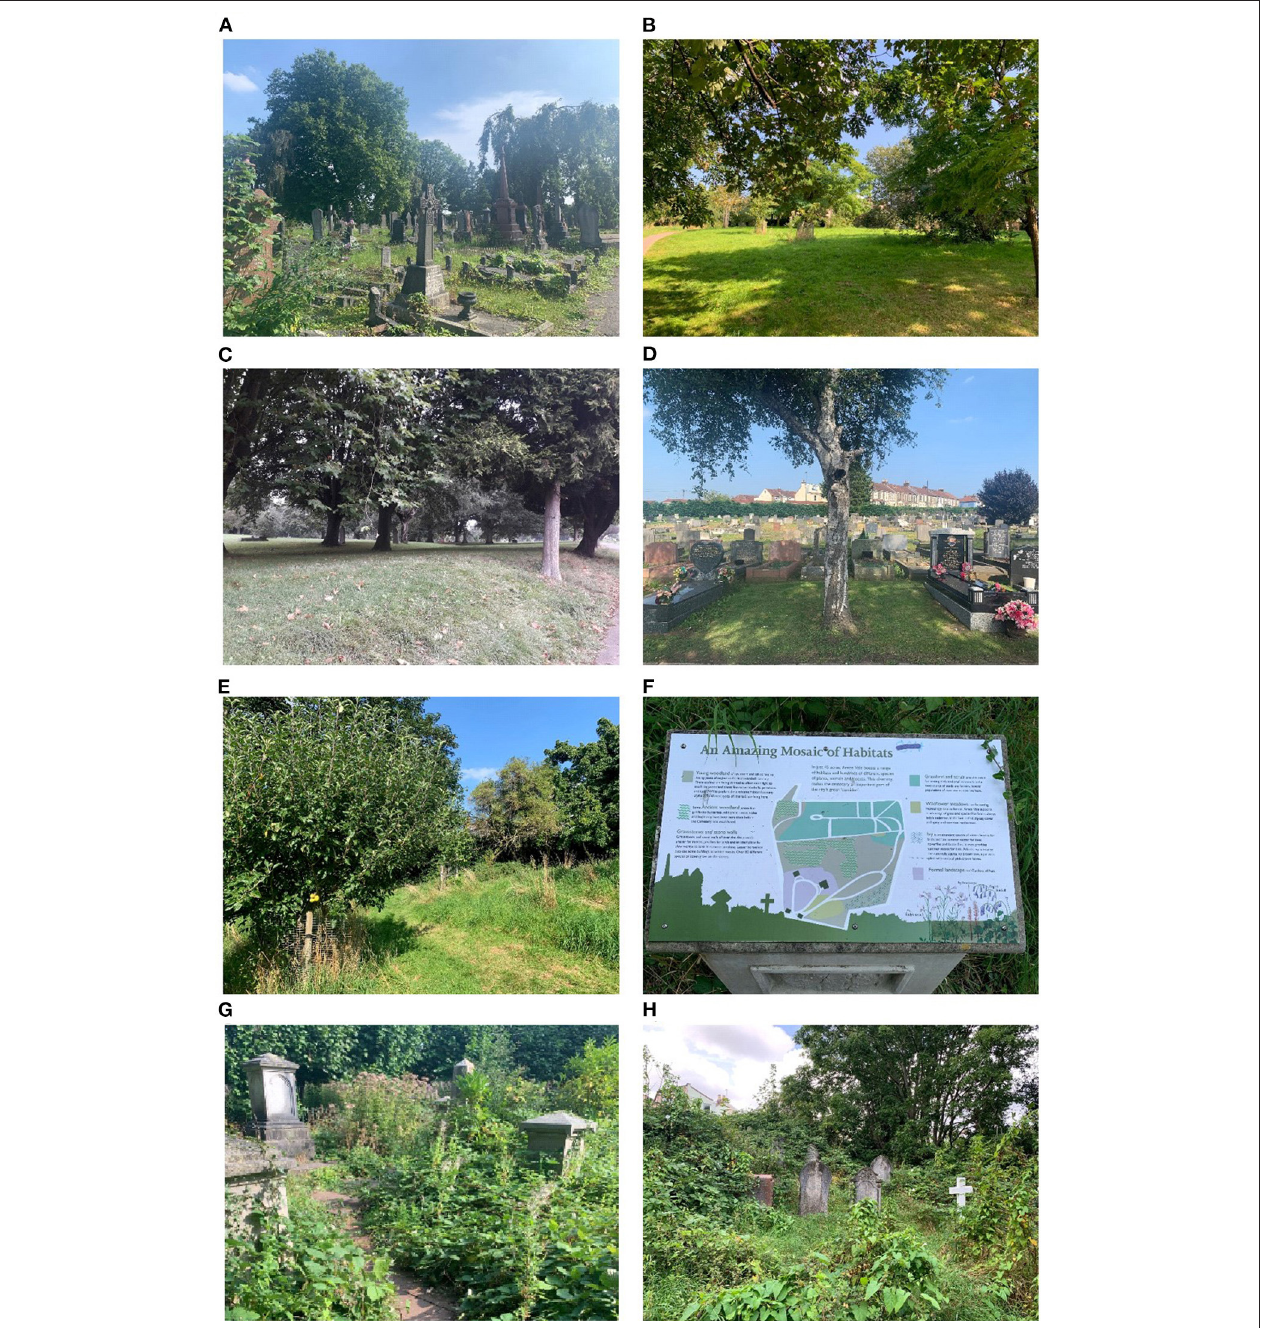
FIGURE 4 | Examples of trees at (A) Avonview Cemetery, (B) St. John’s Burial Ground and (C) Greenbank, (D) infill burial avoiding damage to trees at Avonview Cemetery, (E) overgrown areas at St John’s Burial Ground, (F) interpretative signage at Arnos Vale, and overgrown graves at (G) Birdcage Walk and (H) Arnos